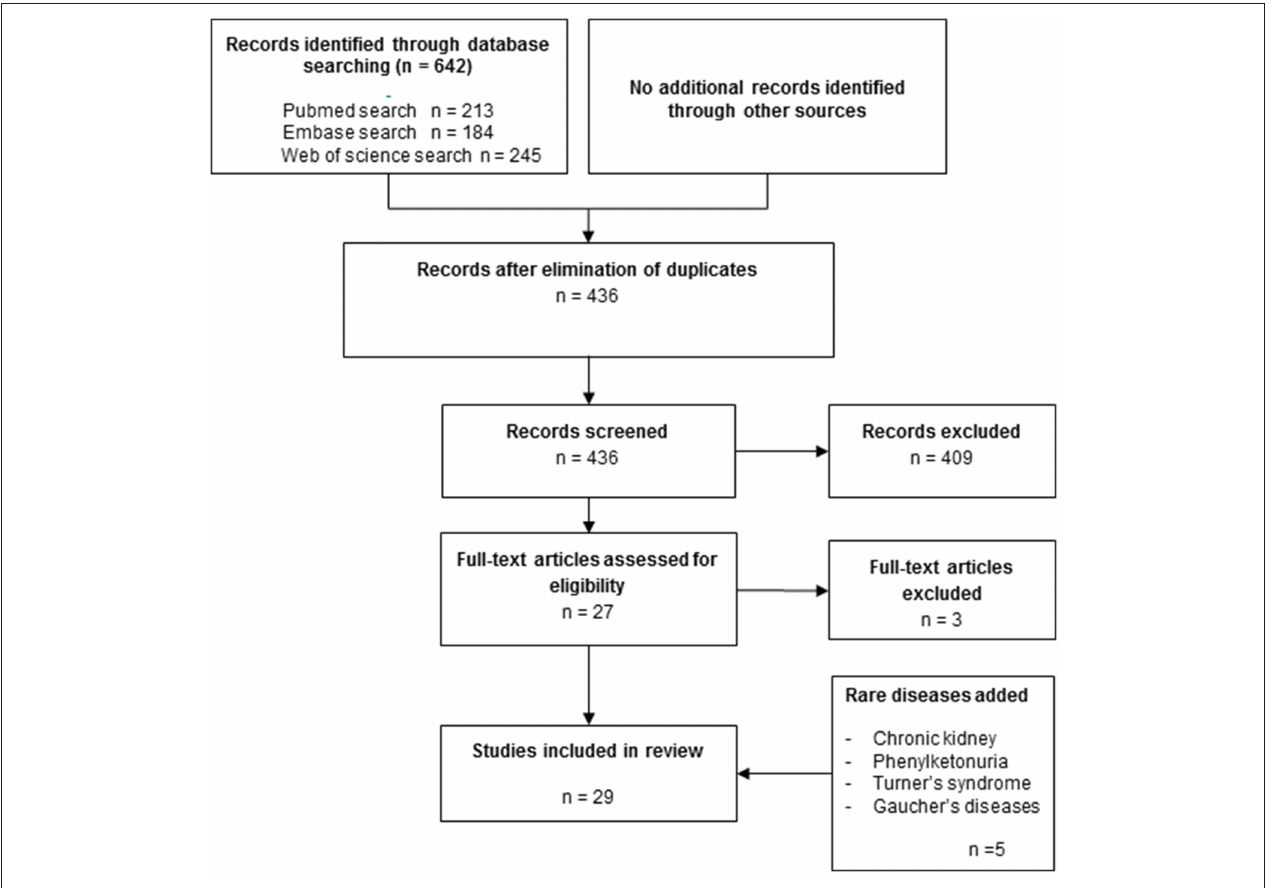
FIGURE 1 | Flow chart of the literature search strategy. PsA patients, while adiponectin was negatively correlated with osteoclast